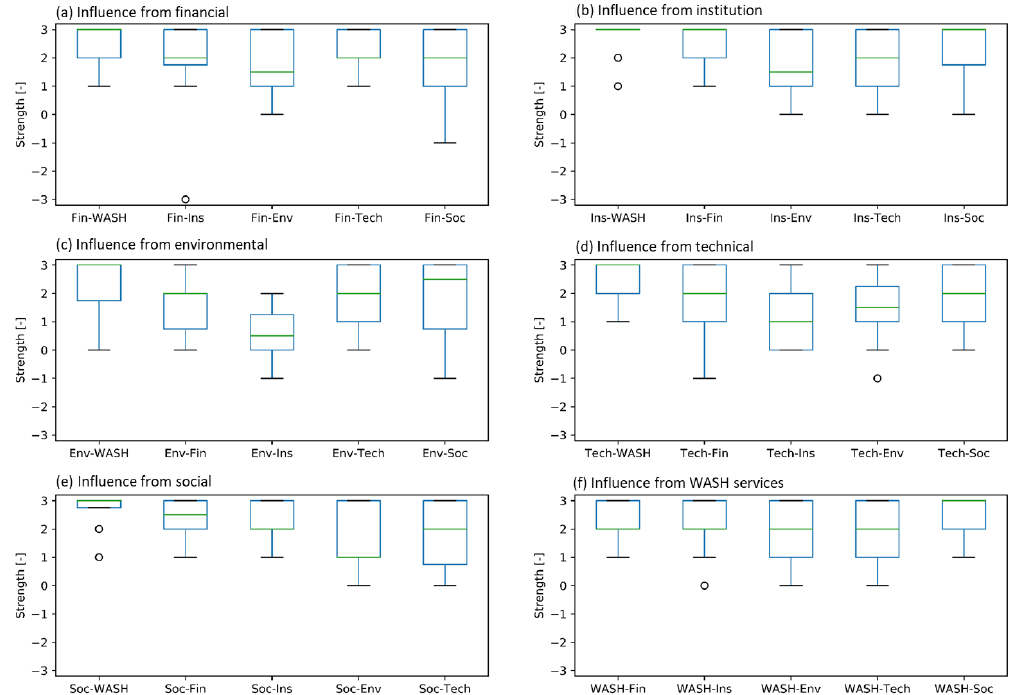
Figure 1. Response distribution from the respondents shown through box plots, e.g., “Fin — Ins” means the influence from financial to institutional. The green line is the median and the dot is a single data point.